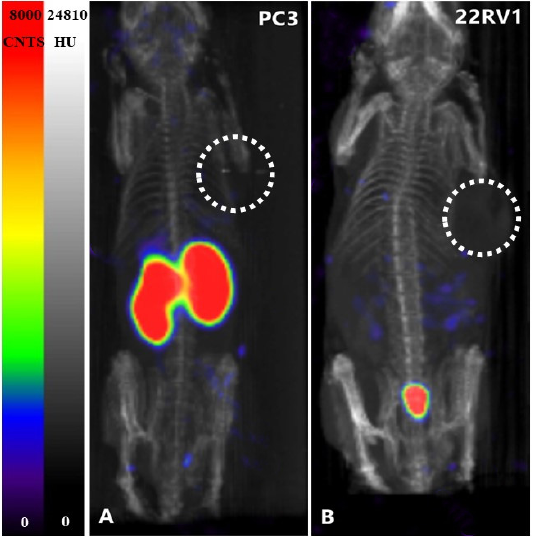
Figure 13. ( A ): SPECT MIP images of PC3 tumor-bearing mice after administration of 1.665 × 10 6 Bq of 125 I-PSMA-7 at 60 min; ( B ): Co-injection of 1.665 × 10 6 Bq i of 125 I-PSMA-7 and ZJ43 in 22RV1 tumor-bearing mice at 60 min.